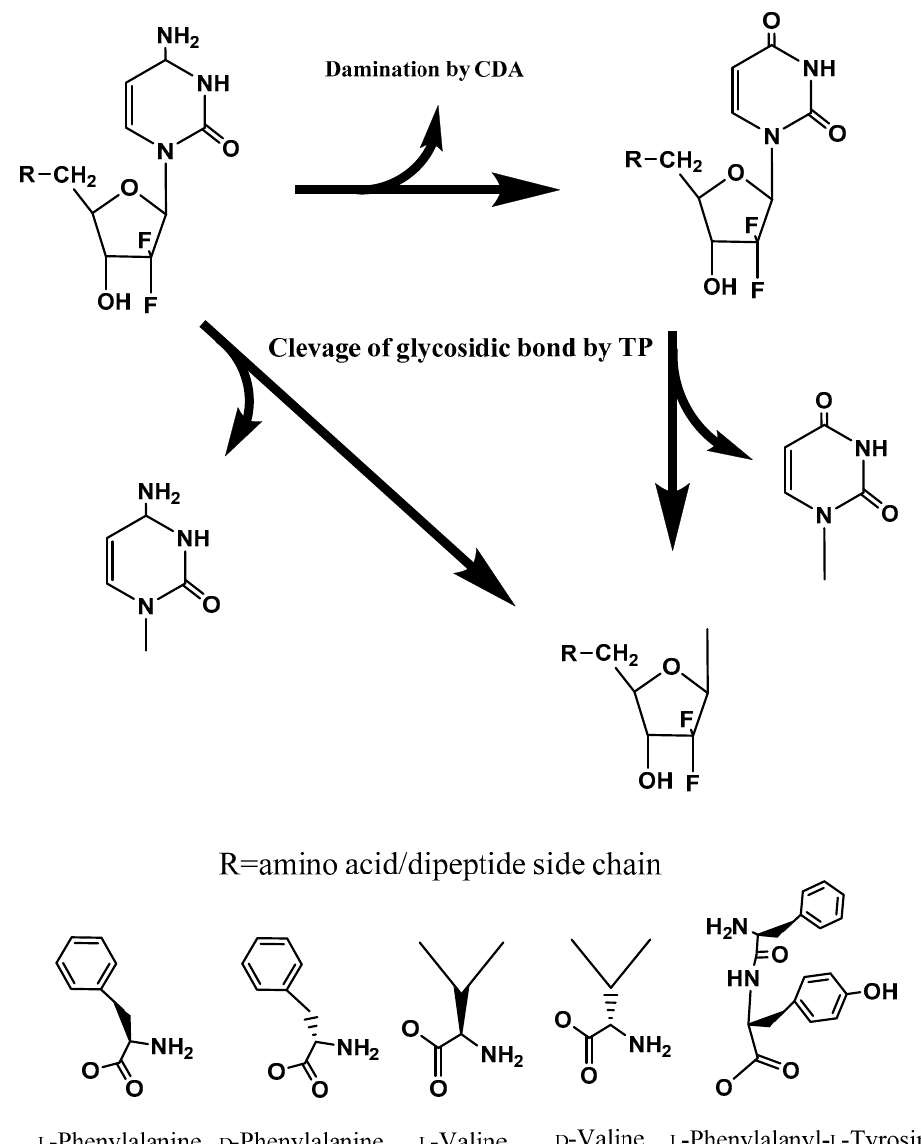
Figure 1. The metabolic pathway of gemcitabine and gemcitabine prodrugs with relevant enzymes.